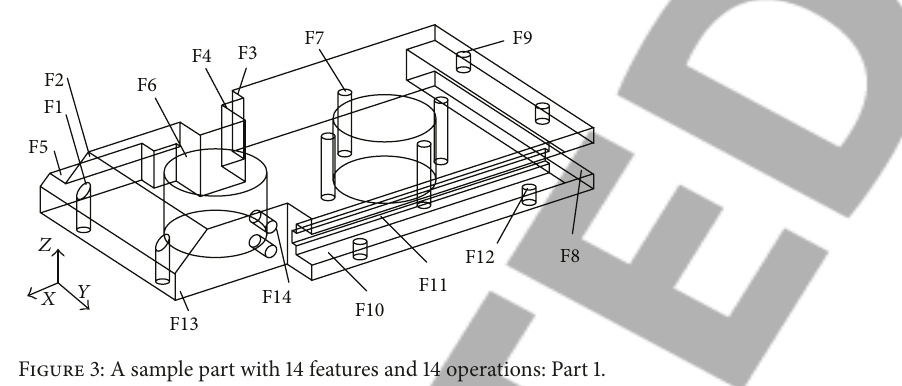
Figure 3: A sample part with 14 features and 14 operations: Part 1.